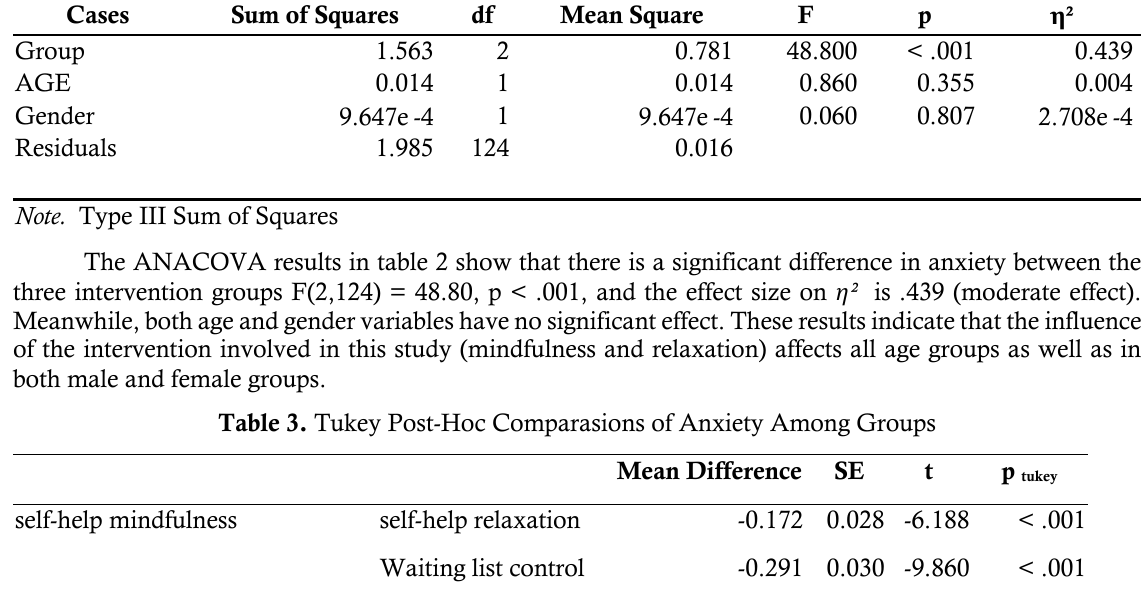
Table 2. The ANACOVA of Gains score Anxiety between groups of study control by Age and Gender Cases